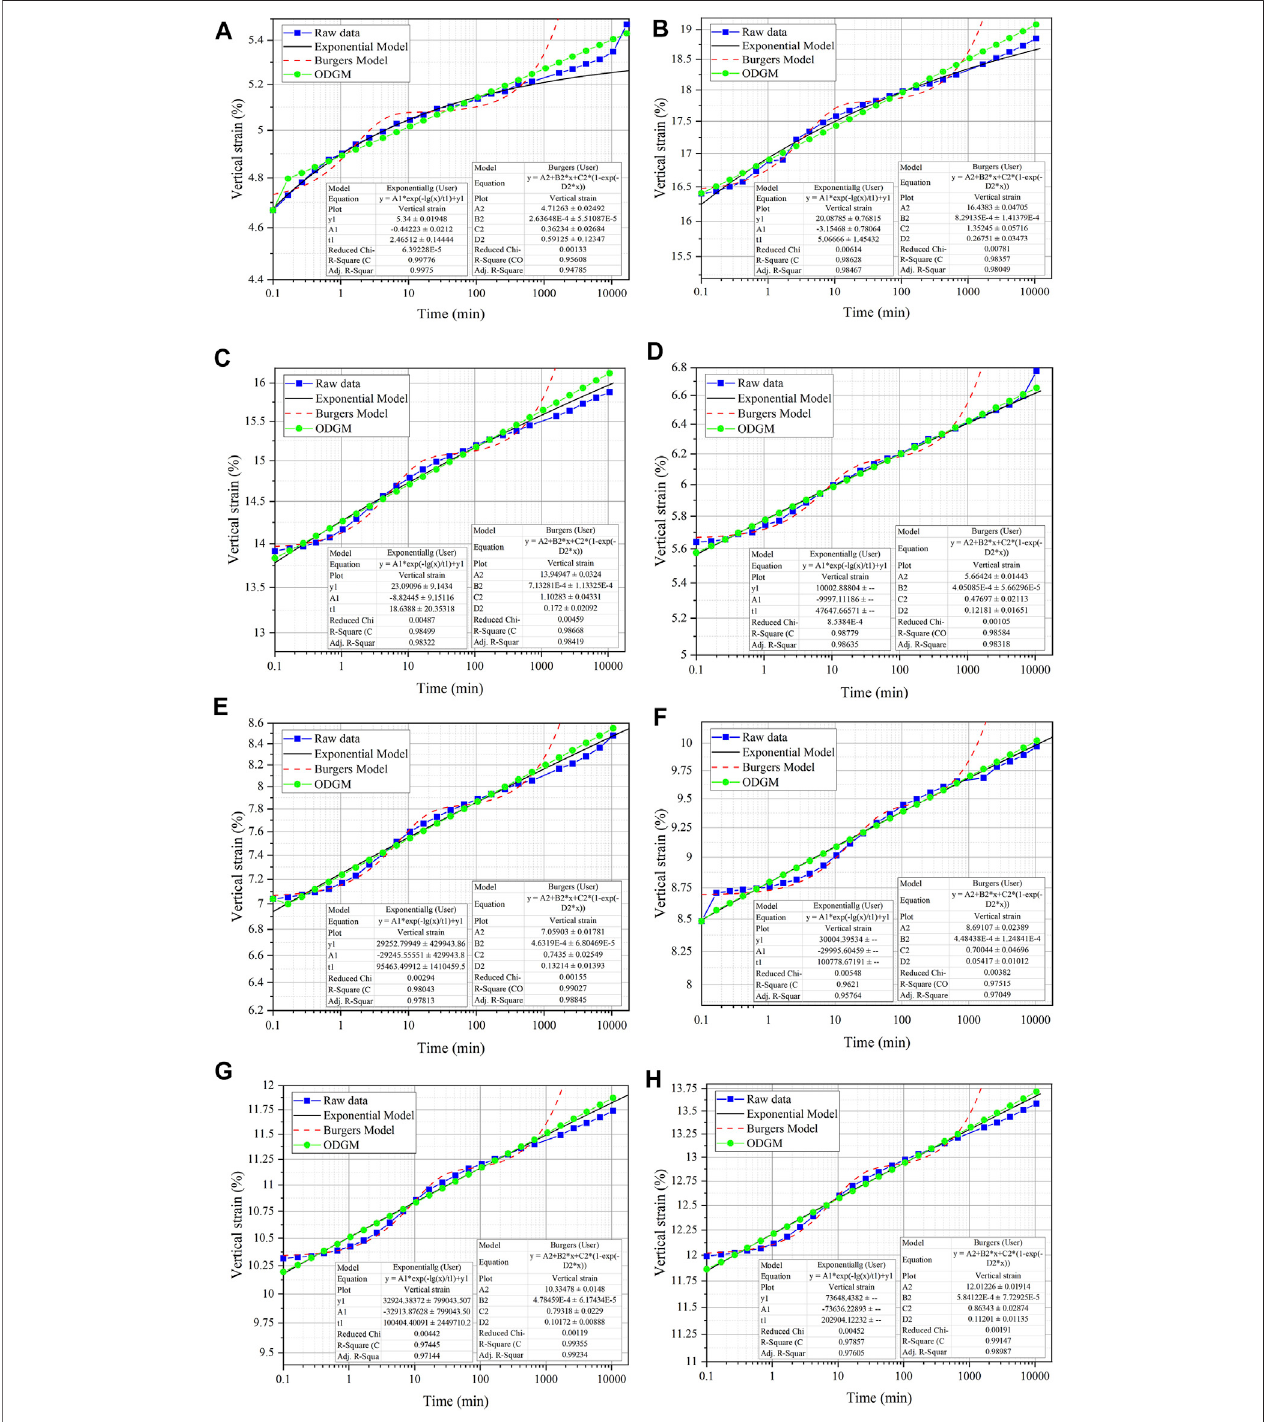
FIGURE5| Relationshipofverticalstrainandtime(log-scale)andpredictionresultsofthreemodelsunderdifferentverticalstresses.(textbf (A) σ =25 kPa,textbf (B) σ =50 kPa, textbf (C) σ =100 kPa, textbf (D) σ =200 kPa, textbf (E) σ =400 kPa, textbf (F) σ =800 kPa, textbf (G) σ =1600 kPa, textbf (H) σ =3200 kPa)